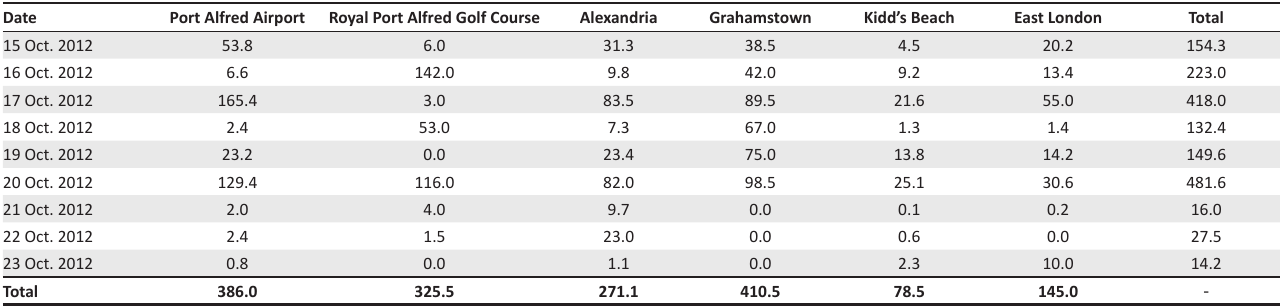
FIGURE 3: Surface synoptic chart on 20 October 2012 at 14:00 SAST. TABLE 1: Daily rainfall values, in millimetres, recorded at rainfall stations in and around Port Alfred. Date Port Alfred Airport Royal Port Alfred Golf